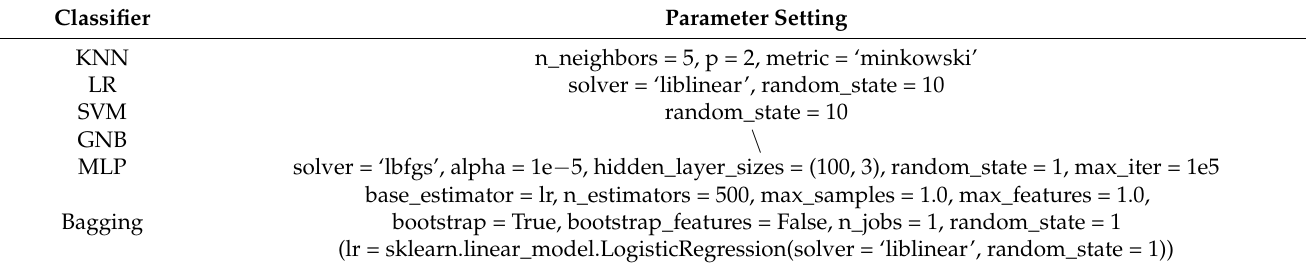
Table 3. Parameter settings of the examined classifiers in sklearn. Those parameters that are not listed in this table are set as the default values, while “ \ ” represents that all the used parameters are the default